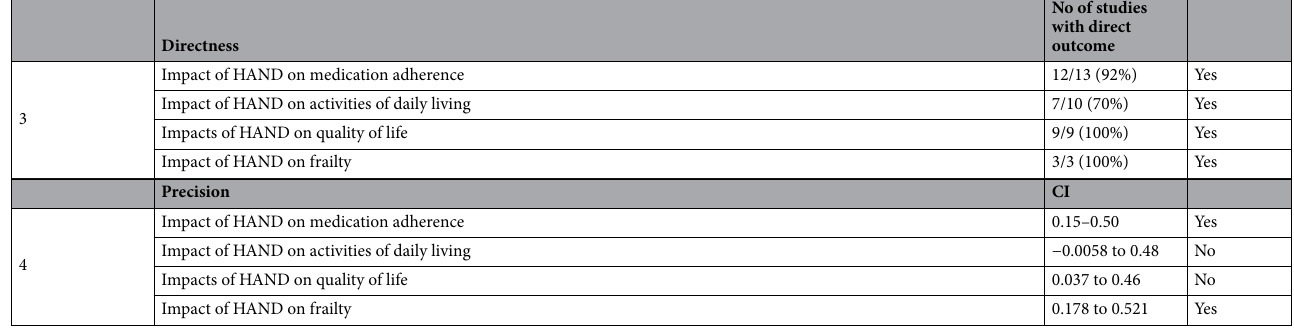
Table 1. Strength of evidence. RoB Risk of bias; CI Confidence interval.